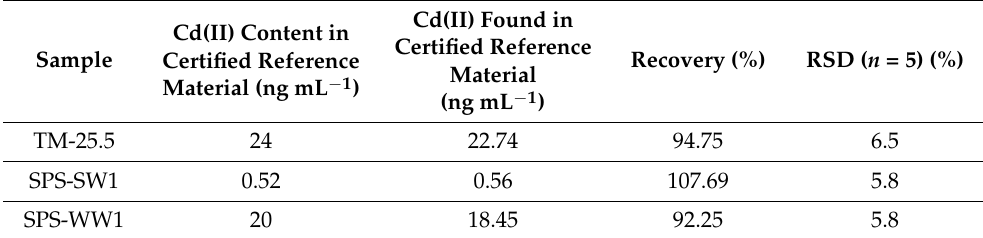
Table 4. Analytical results of Cd(II) determination in the certified reference materials without and with addition of Cd(II) ions. The samples were examined using the standard addition method.